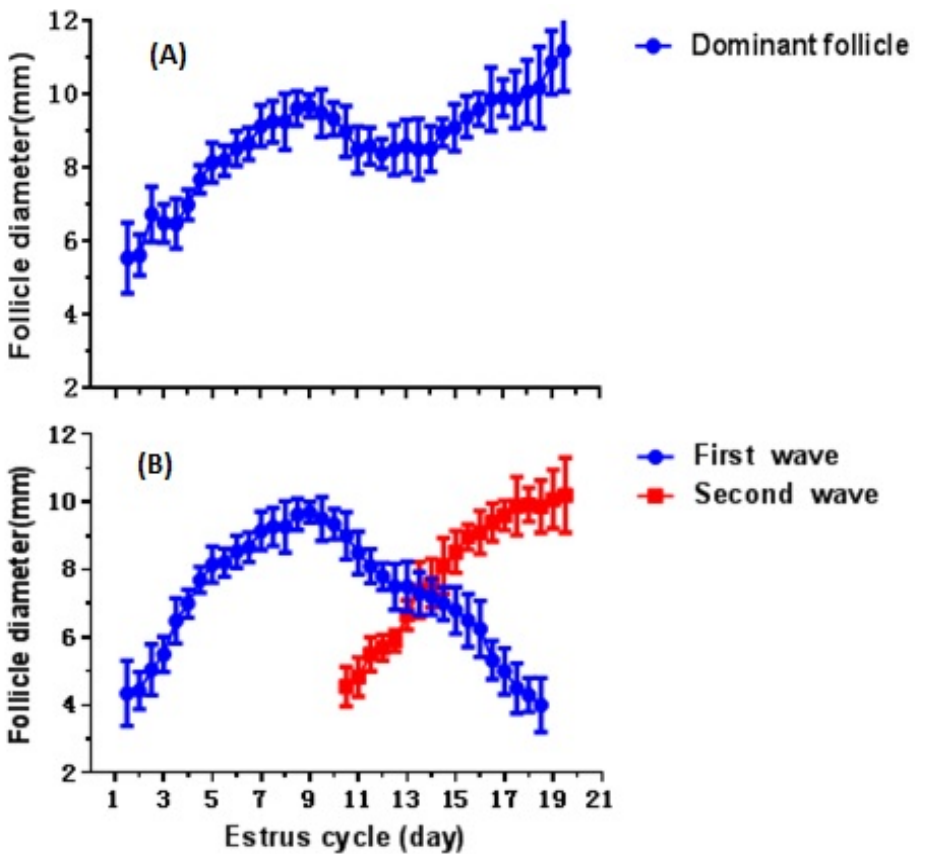
Figure 1. The growth profile of DF in pubertal buffaloes with a one- (( A ), n = 3) and two-wave (( B ), n = 25) estrous cycle.